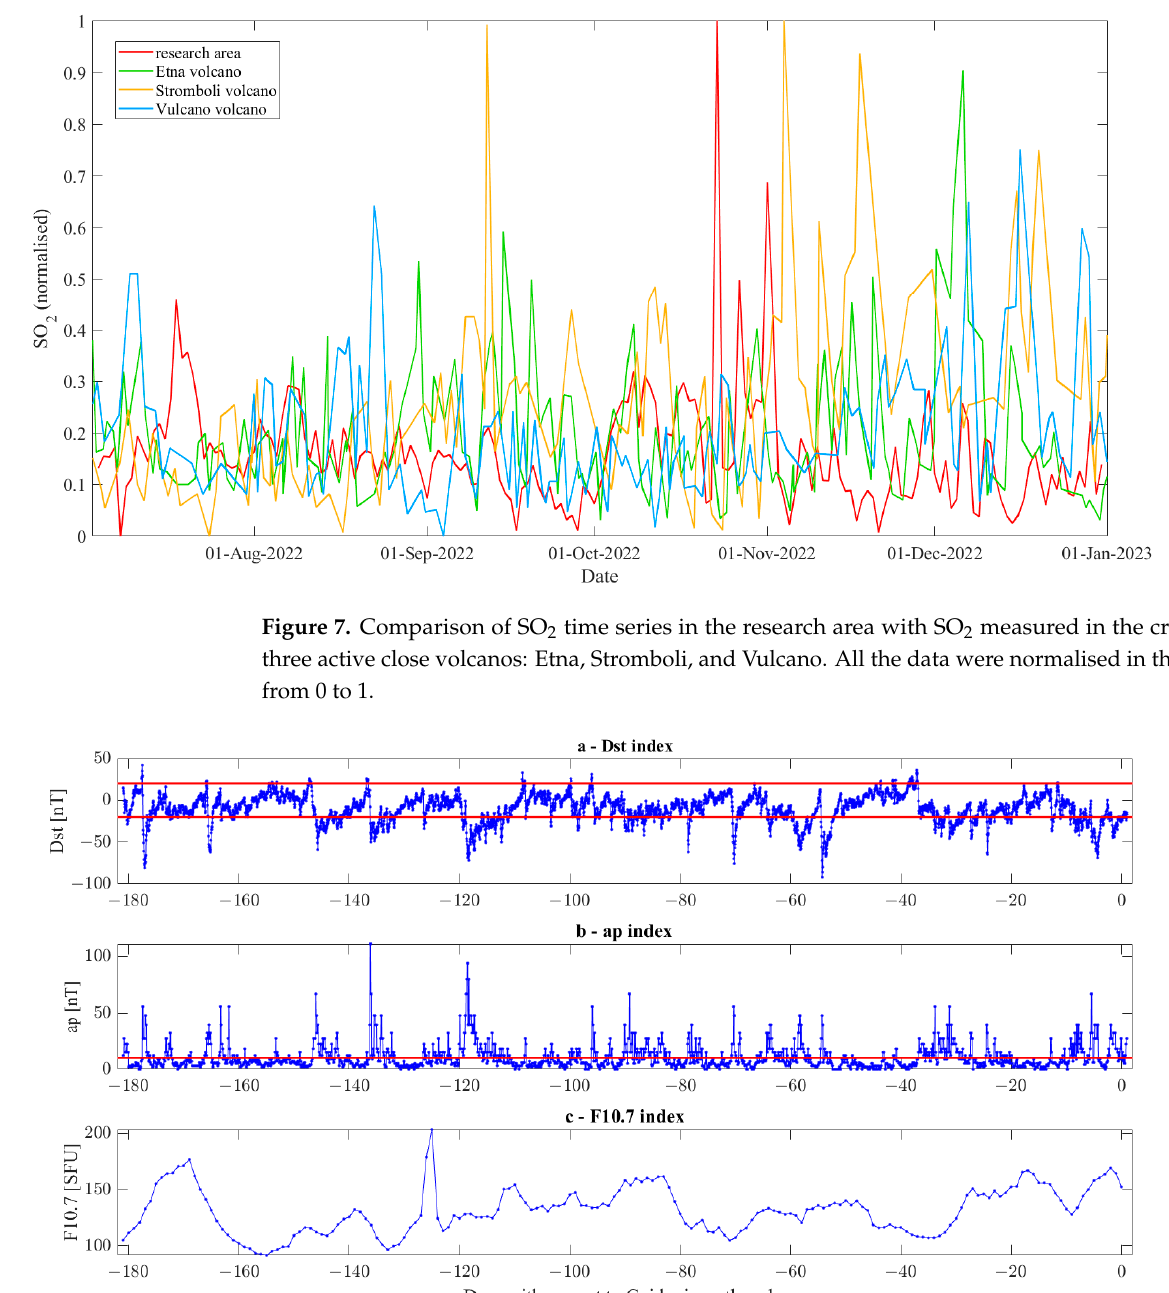
Table 3. List of the Swarm anomalous tracks in the circular research area of 235 km of radius centred on the ML3.3 Guidonia 1 January 2023 earthquake. Swarm